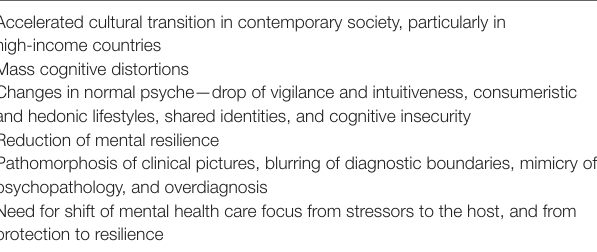
TABLE 1 | Changes in psychopathology—key